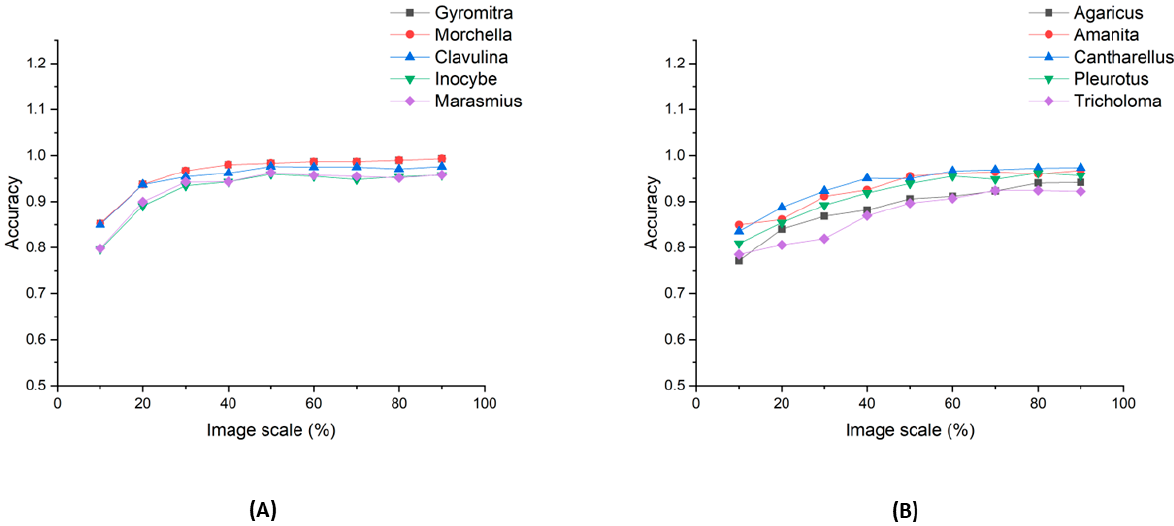
Figure 7. Comparison of relative accuracy when image sizes are varied. ( A ) For 3-class model ( B ) 5-class model. When image size falls below 20–25%, overall accuracy decreases to ~80% range.